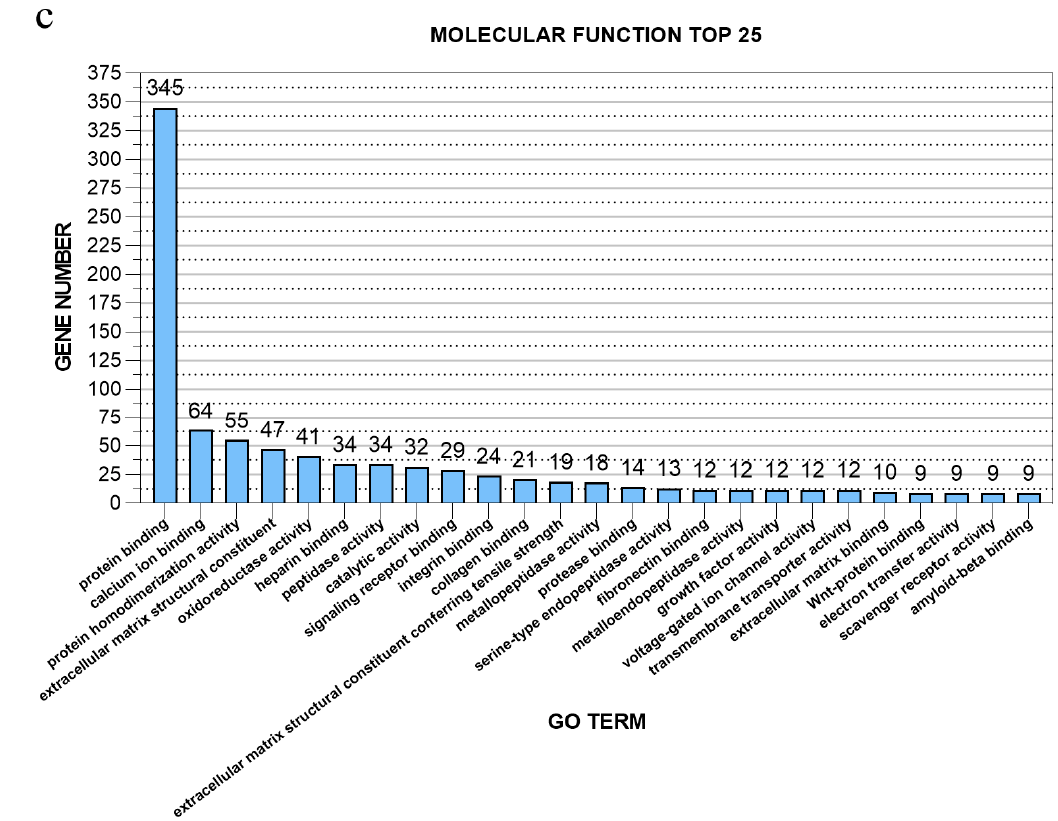
Figure 6. Top 25 significant gene ontology (GO) terms by gene count for Biological Process category (a), Cellular Component (b), and Molecular Function (c).